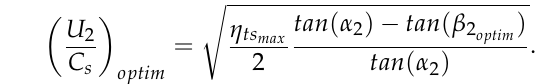
(plotted for η ts = 0.7); ( b ) Sensitivities to max optim = − 30 ◦ and η ts = max optim